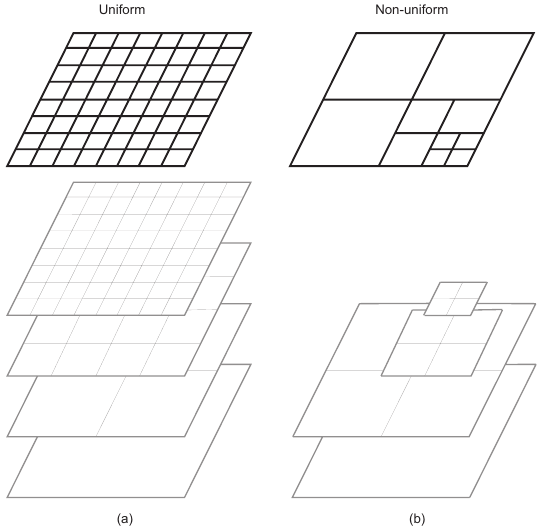
Fig. 1. (a) An example of the hierarchy of uniform grids used in regular geometric multigrid cycles. A standard bisection refinement rule is employed; each quadrilateral element is split into four ele- ments at the next grid level; (b) a non-uniform grid and the uniform levels it is made of. In essence, a non-uniform grid is a union of uniform sub-grids. However, unlike the traditional grids utilized in a multigrid, the sub-grids do not necessarily extended over the same